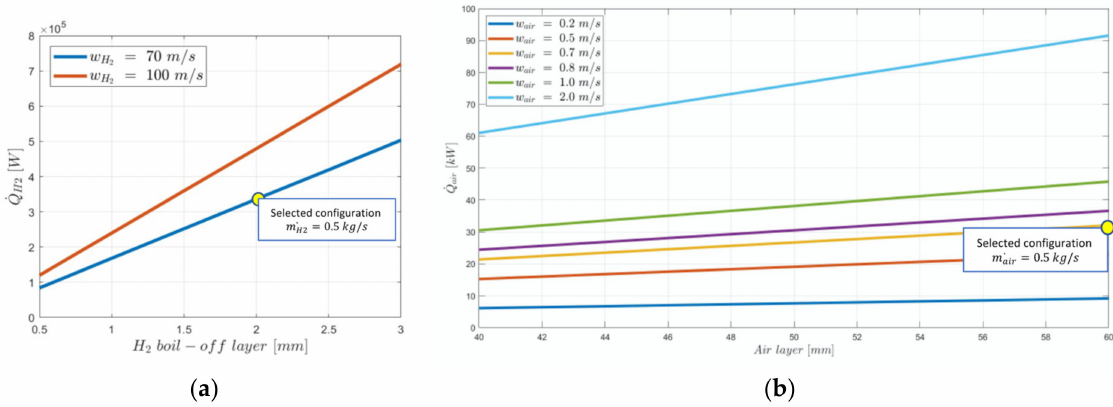
Figure 20. ( a ) Variation of heat loads absorbed by the boil-off hydrogen with the thickness of the insulation layer and different values of the speed of the fluid; ( b ) variation of heat loads absorbed by the air with the thickness of the insulation layer and different values for the speed of the fluid.